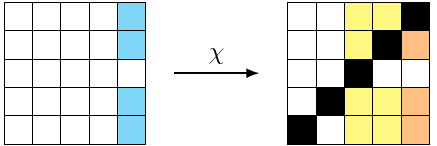
Figure 7: Fixing 4 bits on a slice before χ . The blue bits are fixed so as to linearize the expression of the yellow bits. The orange bits are equal to the bits in blue with probability 0 . 75. The black bits are not of